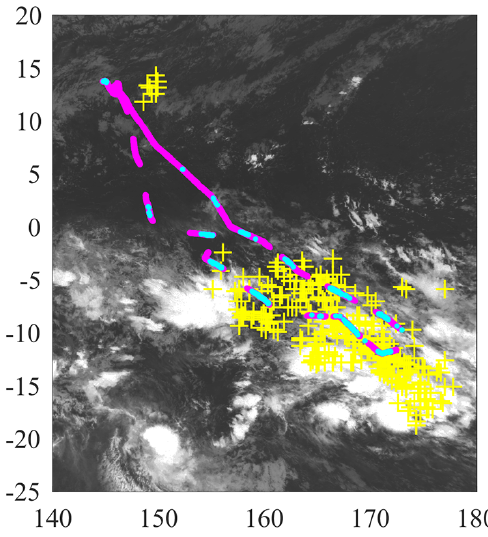
Figure 13. MTSAT infrared satellite image at 18:00UTC on 8 March 2014, around 24h before the midpoint of flight RF05 to coincide with the endpoints of the 24h back trajectories. Tropical Storm Lusi is visible as the cluster of convection centred around 170 ◦ E, 20 ◦ S. The tropospheric ( > 100hPa) portion of the flight track of RF05 is shown in magenta and, in the case where trajec- tories crossed the 800hPa isobaric surface, in cyan. The positions after 24h of the trajectories that crossed the 800hPa isobaric surface at some point in the model are marked as yellow crosses.